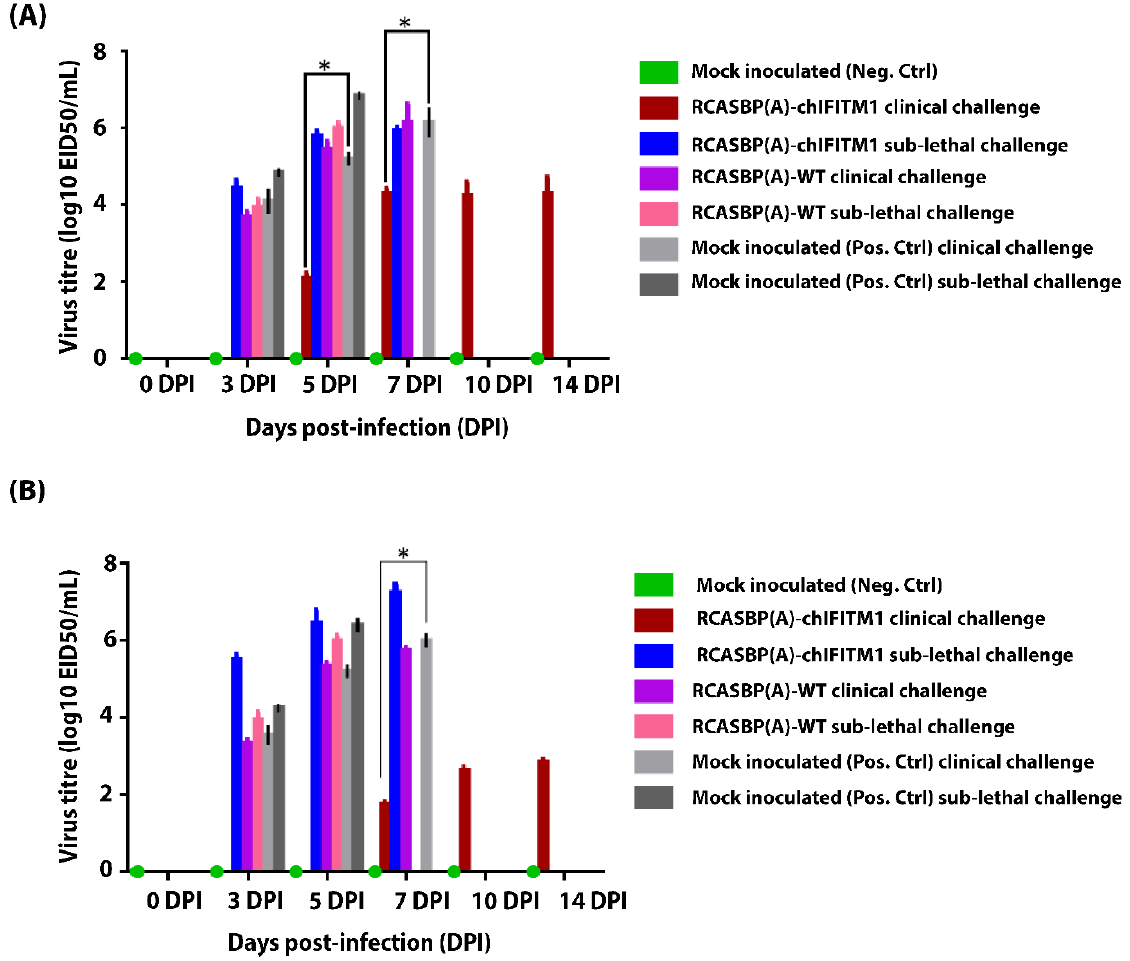
Figure 4. Evaluation of viral shedding from ( A ) oropharyngeal and ( B ) cloacal swabs of RCASBP(A)-chIFITM1 and RCASBP(A)-WT challenged chicks with clinical and sub-lethal doses of H5N1 HPAIV compared to mock inoculated chicks (negative and positive control groups). Each data point represents the virus titers detected in oropharyngeal and cloacal swabs on day 0, 3, 5, 7, 10, and 14 DPI. Bars represent the standard deviation means. * indicates the level of significance at p value < 0.05.